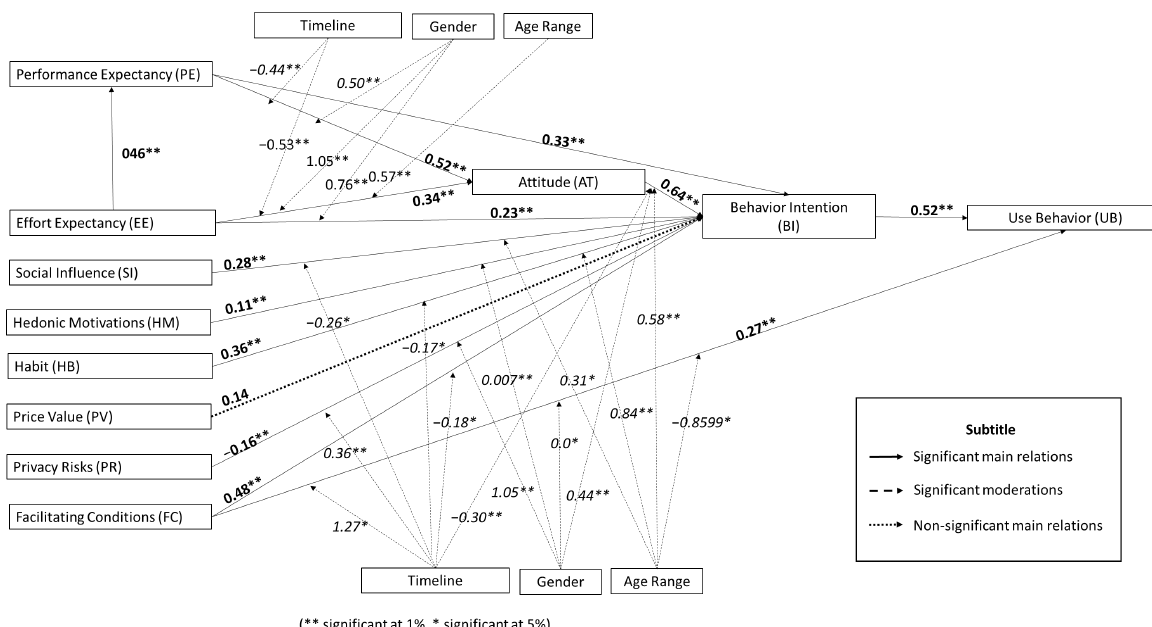
Figure 3. Meta-analysis model for e-health technology acceptance, corresponding to m-health and wearable devices.